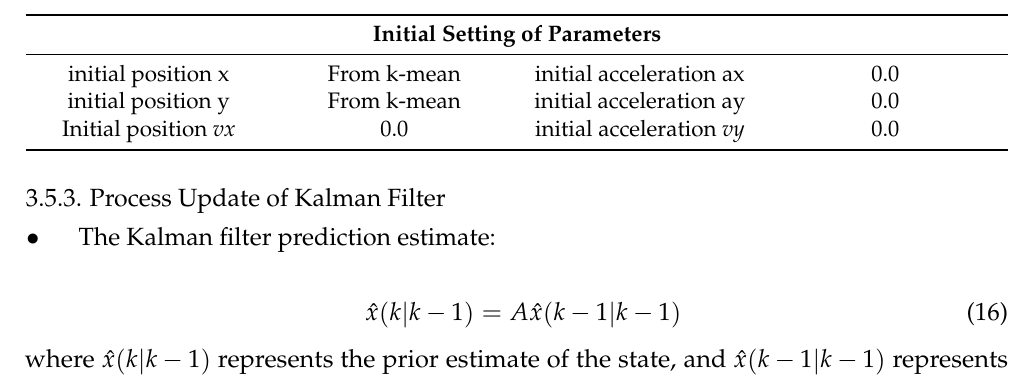
Table 1. Initial parameters of the Kalman